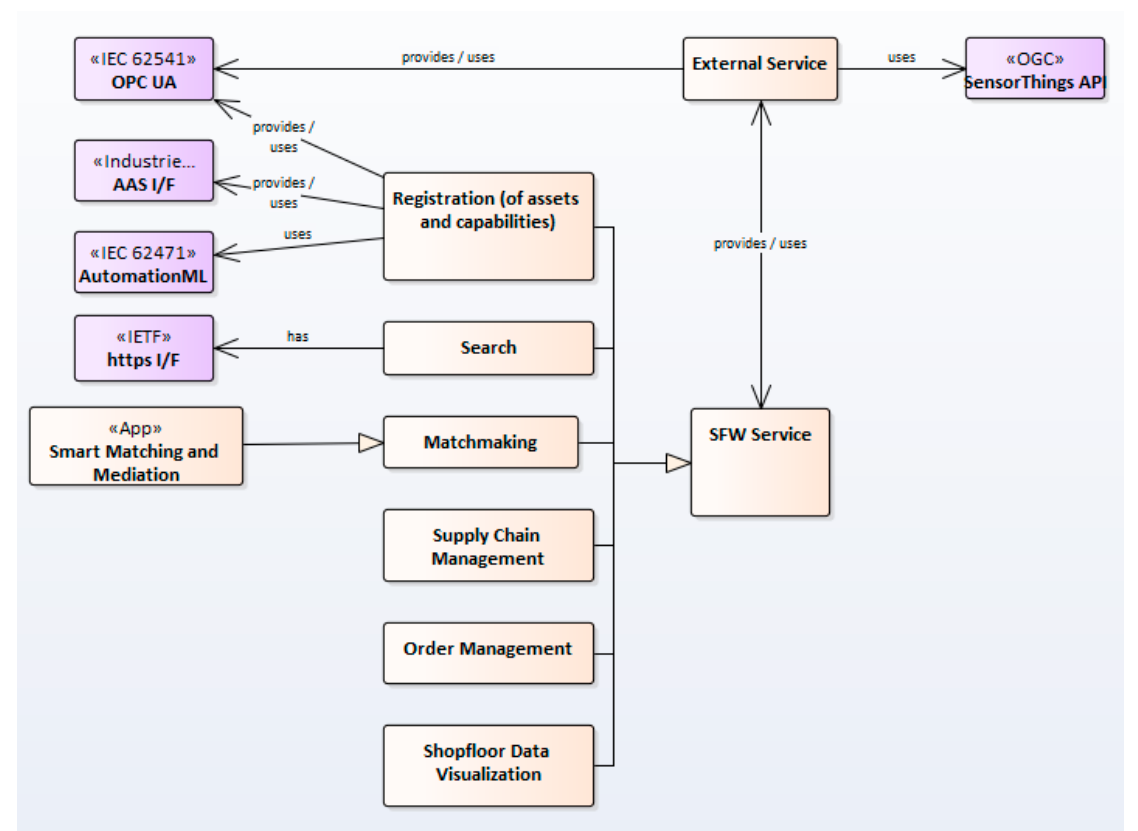
Figure 4. Smart Factory Web architectural details.